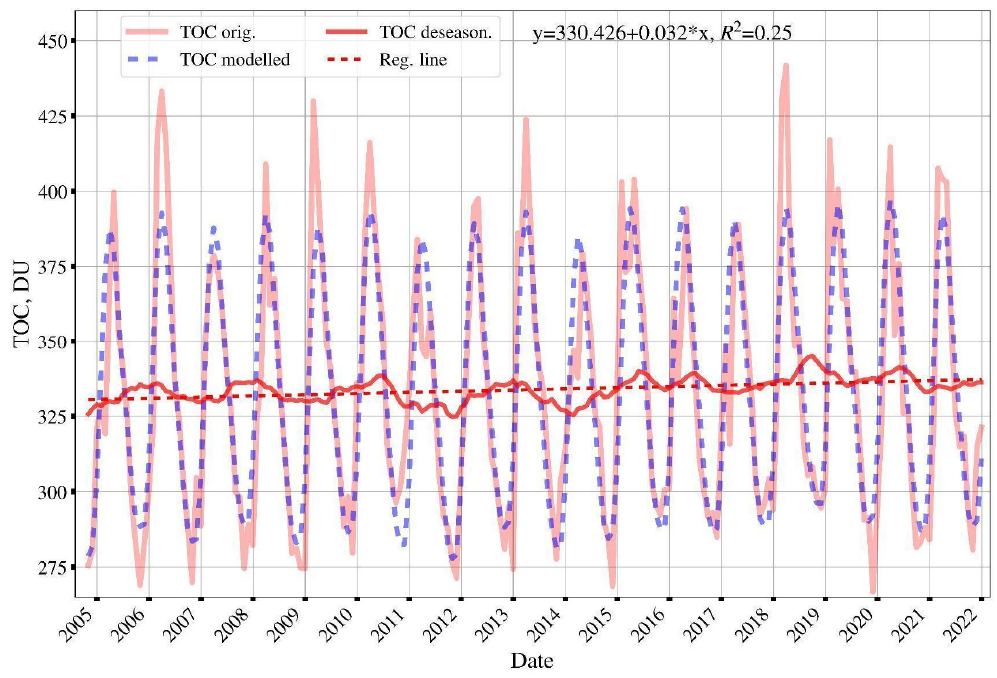
Figure 10. Time series of monthly averaged TOC near St. Petersburg in the 2004–2021 period according to the total mean TOC data (TOC orig.), MLR modelling (TOC simulated), deseasonalized TOC (TOC deseason.) and its linear regression; asterisk “*” represents a multiplication sign.